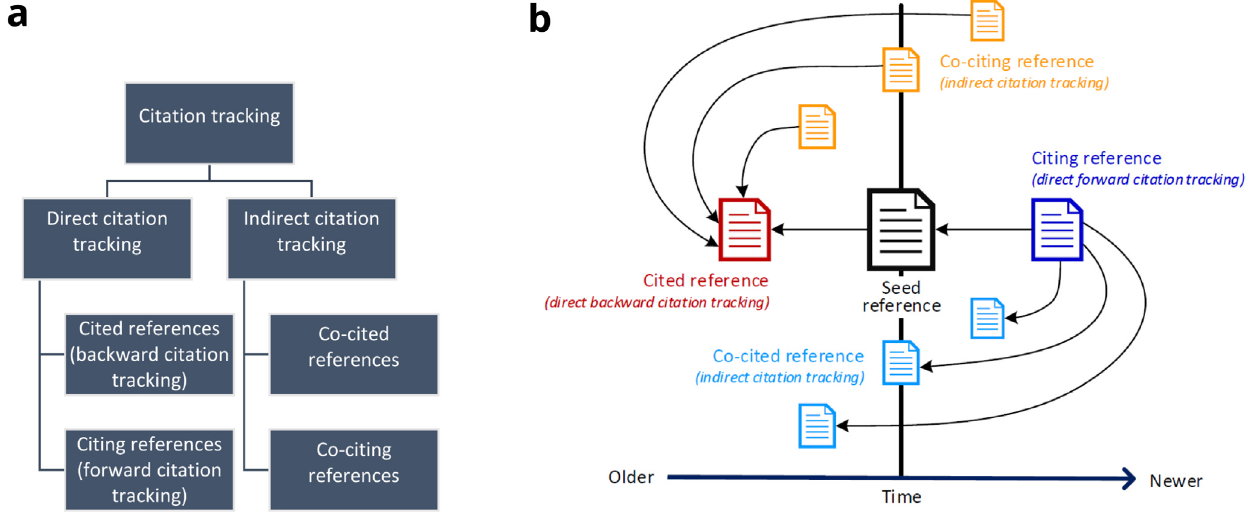
Figure 1. Overview of citation tracking methods. 1a : Hierarchical illustration of different citation tracking methods; 1b : Direct and indirect citation relationships of references based on a seed reference. A → B denotes A cites B. The horizontal axis denotes time, i.e. the chronology in which references were published relative to the seed reference: “Older” stands for references that were published before the seed reference, “Newer” stands for references that were published after the seed